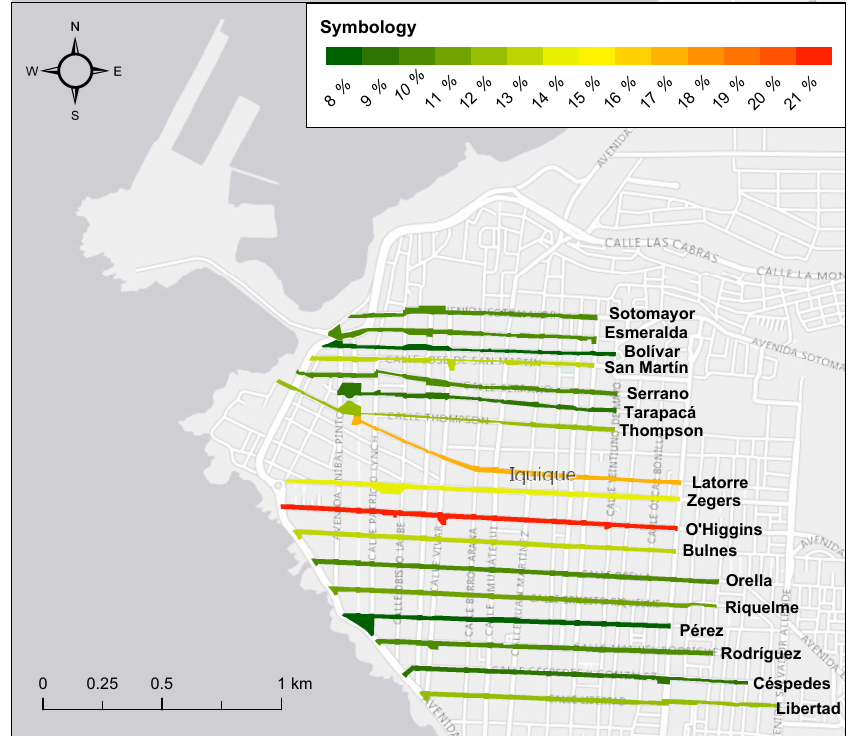
Figure 6. Friction rates obtained for the evacuation routes in the study area.